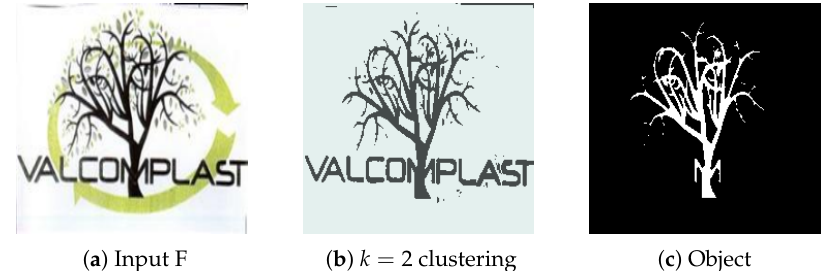
Figure 16. ( a ) Experiment F input; ( b ) Experiment F K-Means clustering ( k = 2); ( c ) Experiment F extracted region for d =